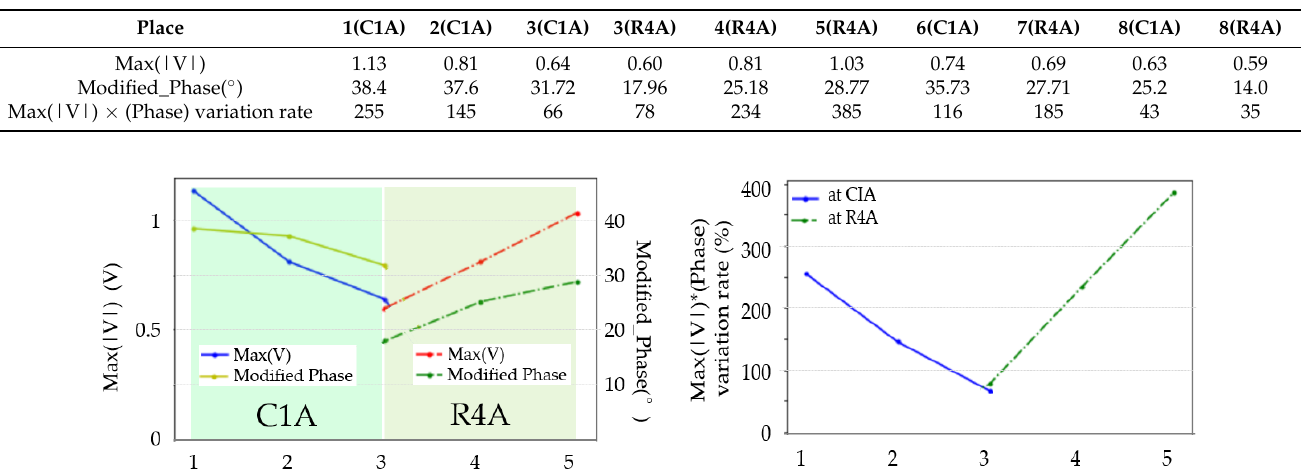
Table 4. Voltage and phase variation according to positions.